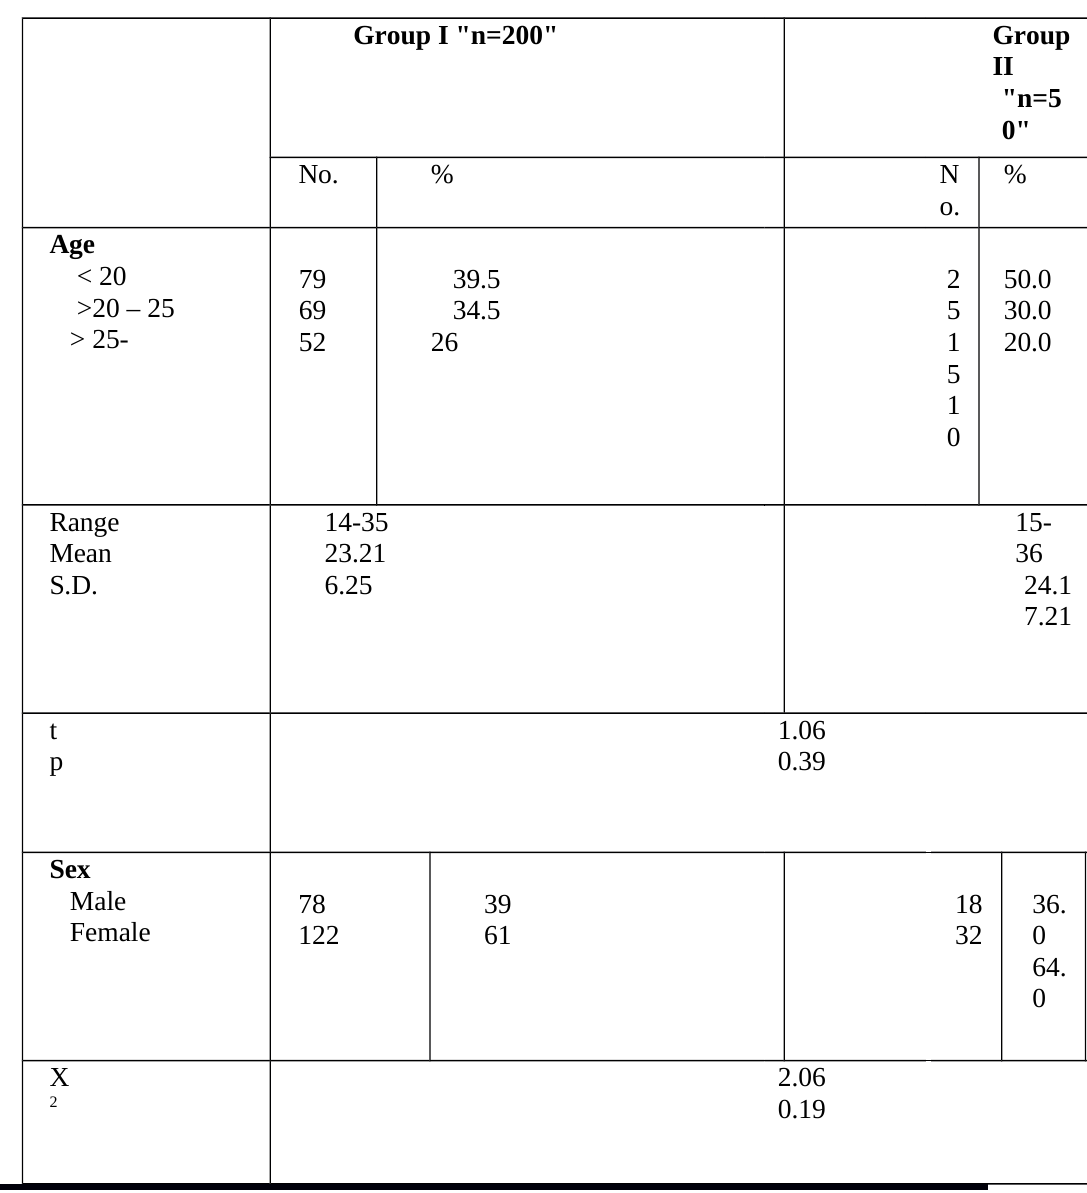
Table (3): Demographic data of the studied patients